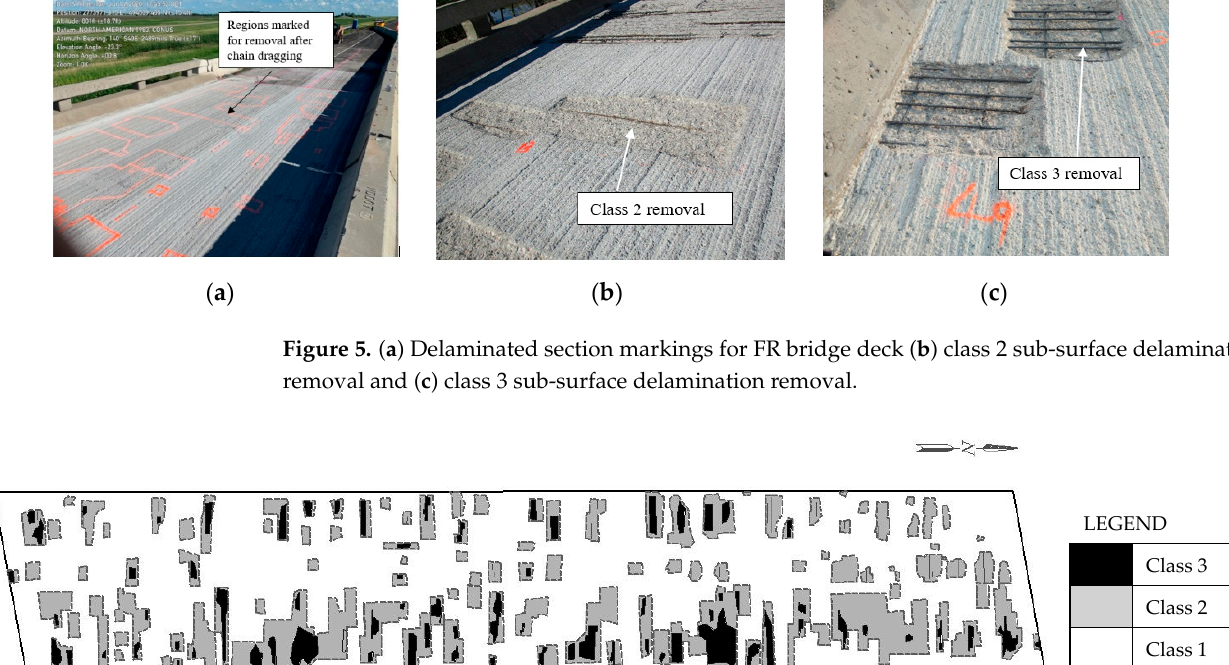
solid boundaries, solid boundaries, respectively.